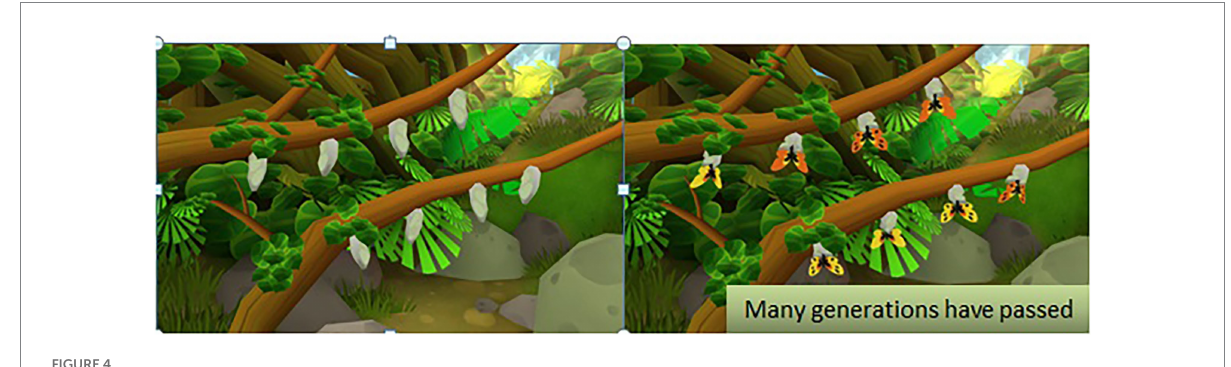
FIGURE 4 The cutscene between